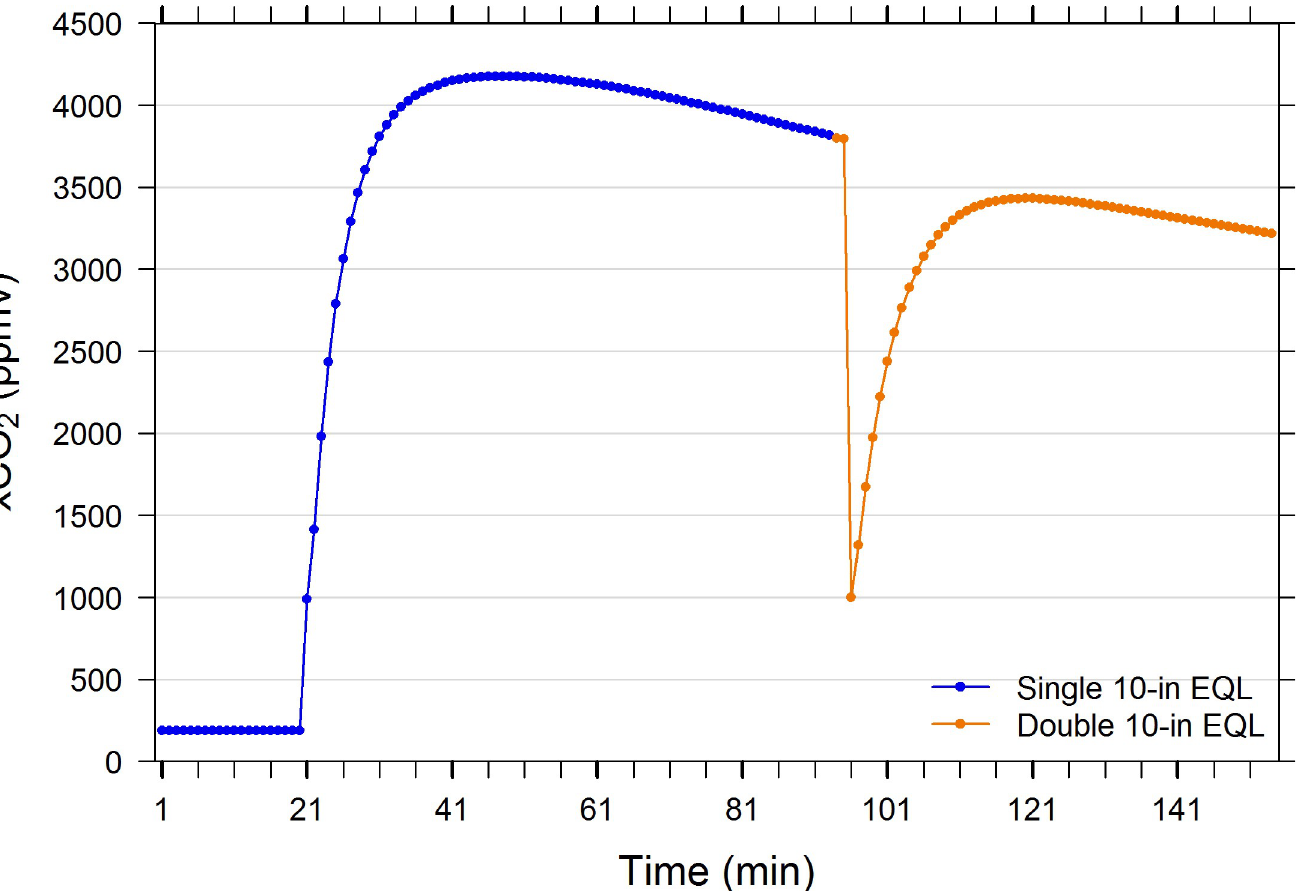
Fig 3. Performance comparison of a single 10-in diameter spherical equilibrator with a two stacked 10-in diameter spheres in a large chamber. Water hose and sample air lines to air pump and IRGA circuit were rapidly switched manually between EQLs for comparison. Water tank was enriched with compressed CO 2 at min 20. The single 10-in EQL was swapped for the double 10-in EQL (containing ambient room air) at min 94 –note 2-min dead time prior to sensor response. See Table 2 for EQL specifications.